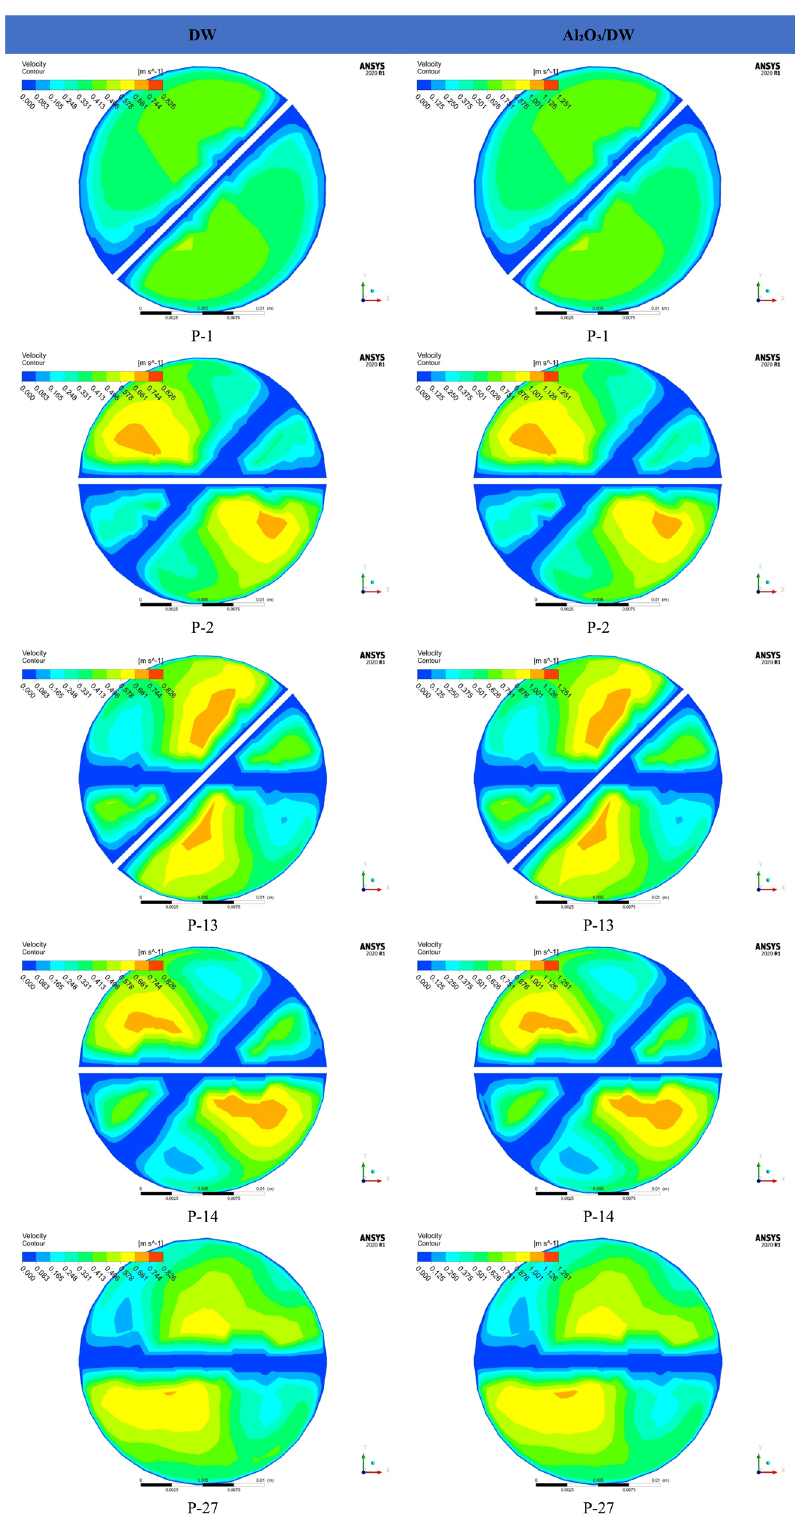
Figure A1: Velocity pro fi les of DW, single, hybrid, and triple nano fl uids under di ff erent planes at Re =